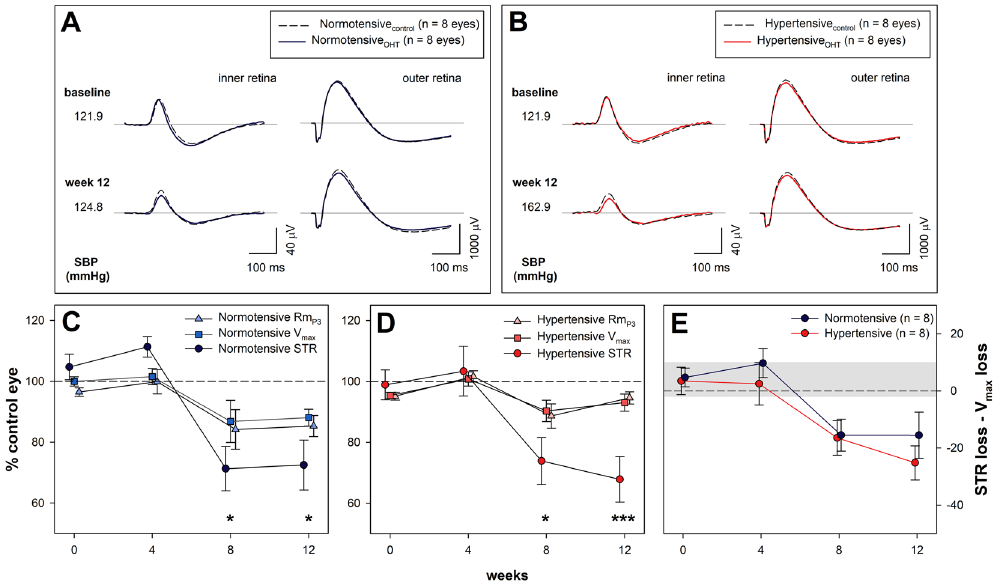
Figure 4. Effect of circumlimbal suture on retinal function in normotensive and hypertensive rats. ( A , B ) Group average ERG waveforms at baseline and week 12 in sutured eyes in normotensive (blue trace) and hypertensive (red trace) animals. The dashedblack lines represent the group average waveform in the unsutured control eye in each blood pressure group. Inner retinal responses are shown for a − 5.31 logcdsm − 2 flash. Outer retinal responses are shown for a 2.07 log cdsm − 2 flash. ( C ) Change in retinal function (mean ± SEM, n = 8) relative to control eyes in normotensive animals. ( D ) Change in retinal function (mean ± SEM, n = 8) relative to control eyes in hypertensive animals. ( E ) Difference between ganglion cell and bipolar cell deficits (pSTR% − V max %) in hypertensive and normotensive animals. The shaded region indicates the 95% confidence interval derived from all animals at baseline. * Indicates p < 0.05, *** Indicates p < 0.001 for post-hoc comparisons of change in Rm P3 versus STR, and V max versus STR amplitudes at each